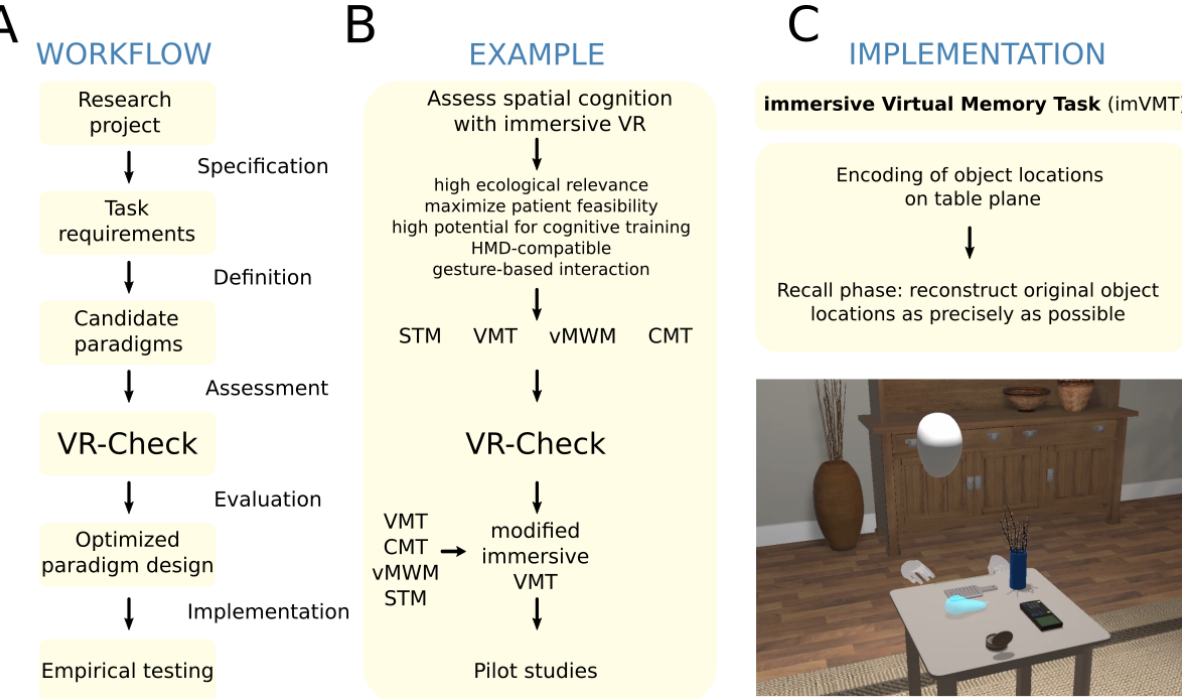
Figure 2. Workflow of the VR-Check evaluation. Panel A summarizes the main general steps for paradigm optimization with the virtual reality check framework. Panel B shows how this workflow applies to an exemplary research project on the assessment of spatial cognition with immersive VR (see main text). Four candidate tasks were evaluated: the Starmaze (STM), the Virtual Memory Task (VMT), the Virtual Morris Water Maze (vMWM), and the Cognitive Map Task (CMT). See Figure 3 and the main text for details on the VR-Check evaluation. Panel C visualizes the result of the optimization procedure: the immersive Virtual Memory Task (imVMT). The screenshot displays a third-person view of a user memorizing the locations of everyday objects on the table. HMD: head-mounted display; VR: virtual